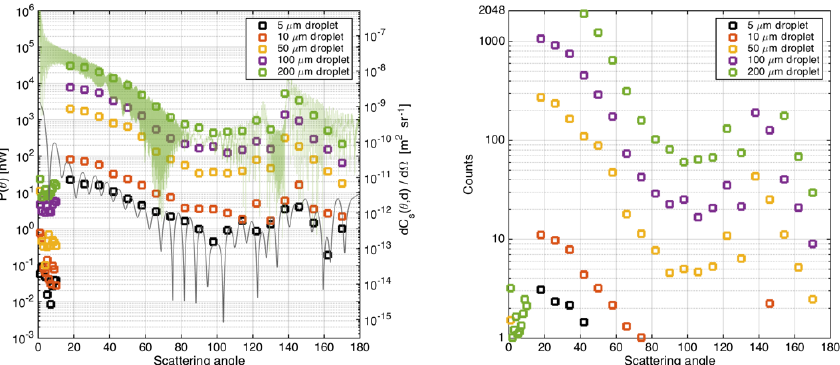
Figure 8. Left: theoretical light power that reaches the detectors by laser light scattering on water droplets with diameters of 5µm (black squares), 10µm (orange squares), 50µm (yellow squares), 100µm (purple squares) and 200µm (green squares). For 5 and 200µm droplets, the scattering cross sections are also shown in high angular resolution. Right: digitized particle scattering functions that are expected for a single MAPMT gain